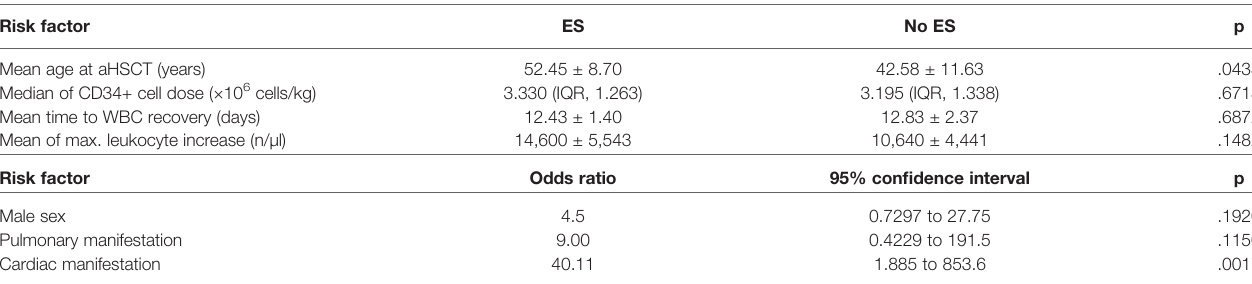
TABLE 4 | Risk factor analysis for